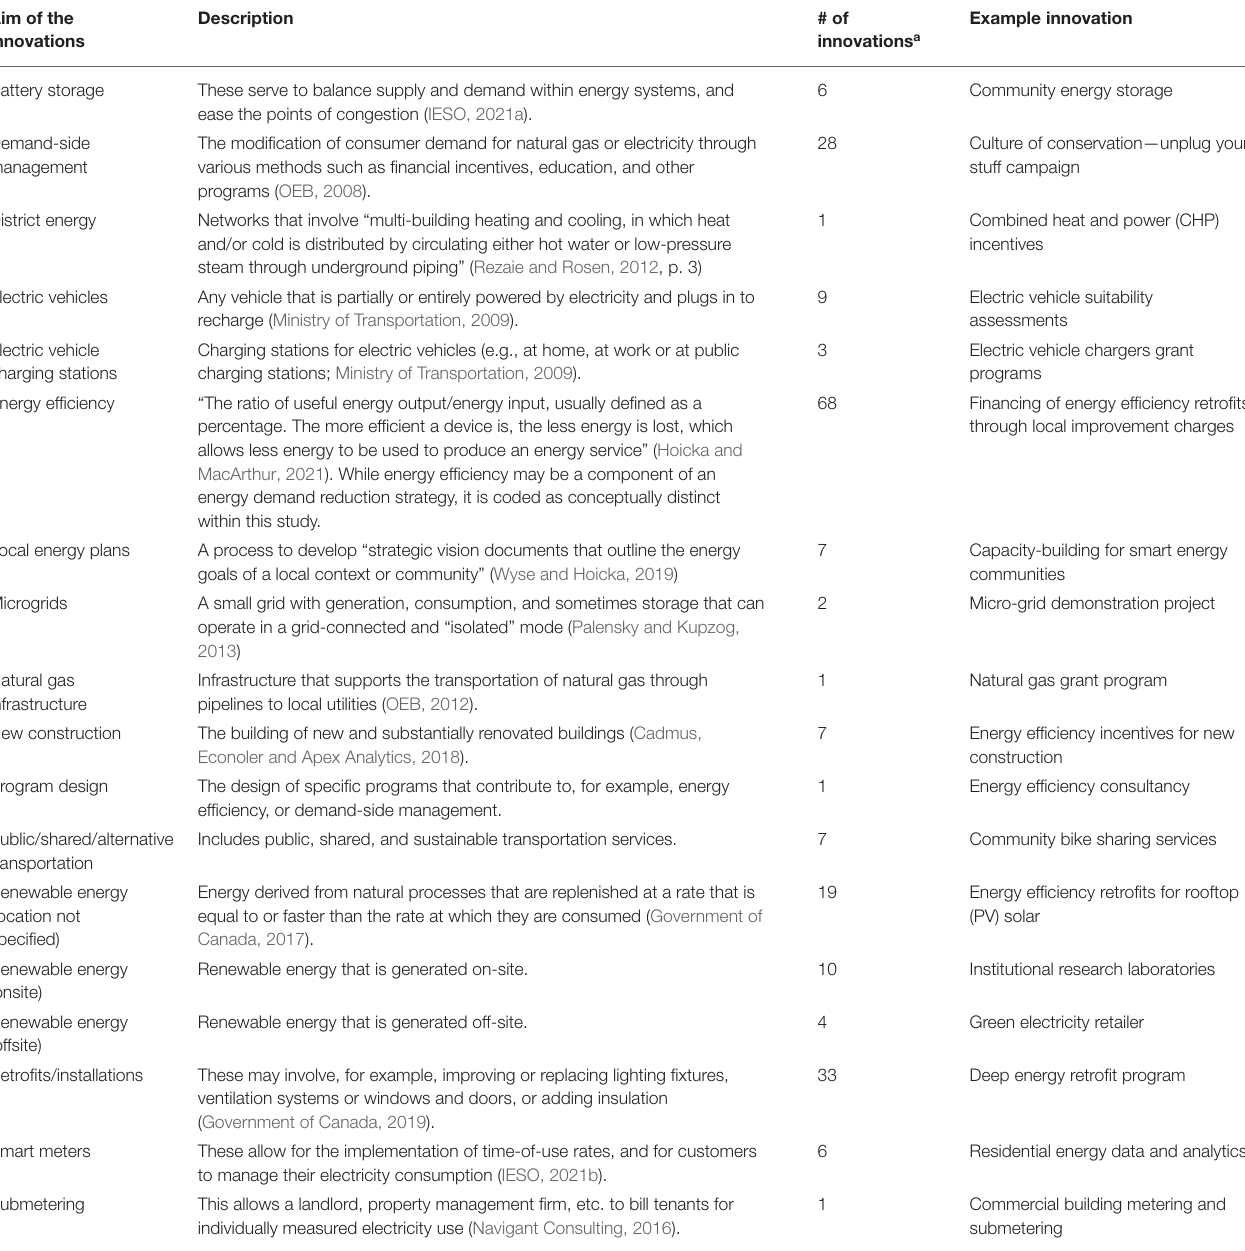
TABLE 4 | Description of innovations in the